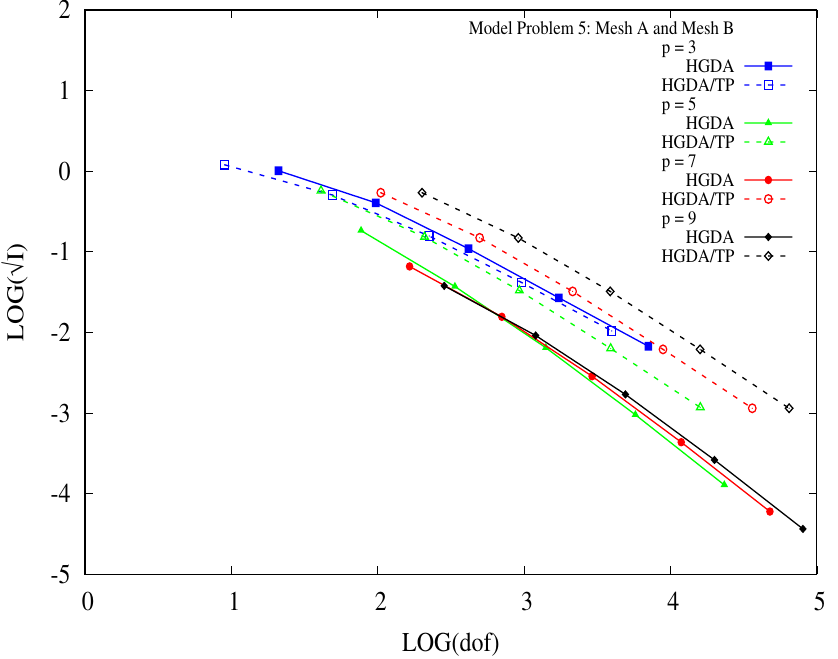
Figure 25. Residual function I versus dof, C 11 solutions: Model Problem 5 (Convection Diffusion Equation; Mesh B, HGDA/DG; Mesh A,